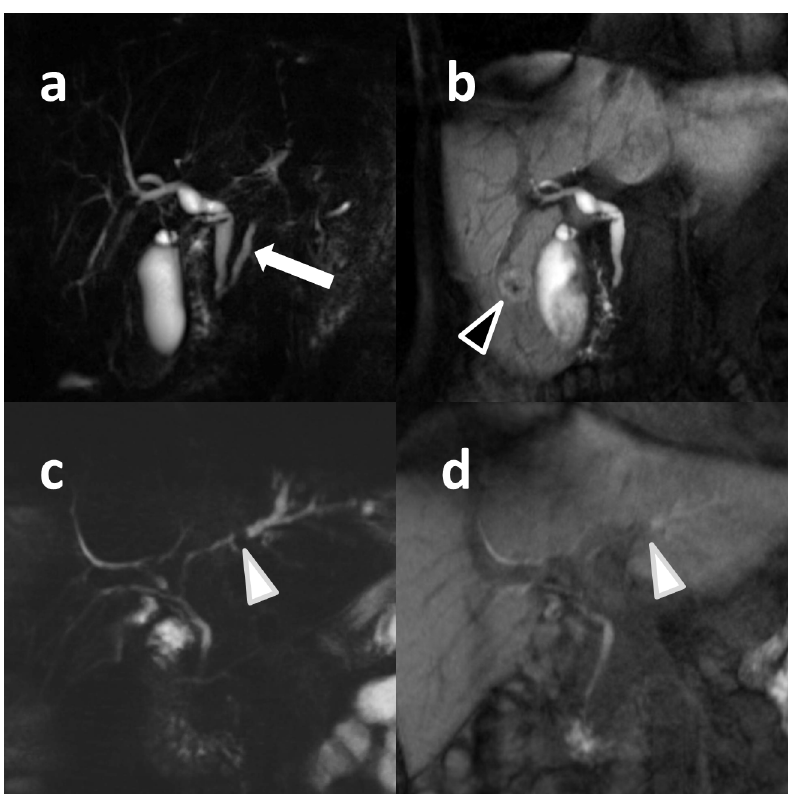
Fig 4. Maximum intensity projection images of the biliary system (a, c: T2 MRCP, b, d: T1 MRC). 53 year-old female patient examined due to suspected focal nodular hyperplasia (black arrowhead in T1 MRC, not visible on T2 MRCP). As contrast in T1 MRC is given by gadoxetate disodium, the pancreatic duct visualized on T2 MRCP (white arrow) is not visualized T1 MRC. Please also note improved conspicuity of the intrahepatic bile ducts on T2 MRCP compared to T1 MRC, which can also be seen on in a 30 year-old female patient (c, d) who was examined due to suspected intrahepatic choledocholithiasis (white arrowheads) which could be verified with MR.